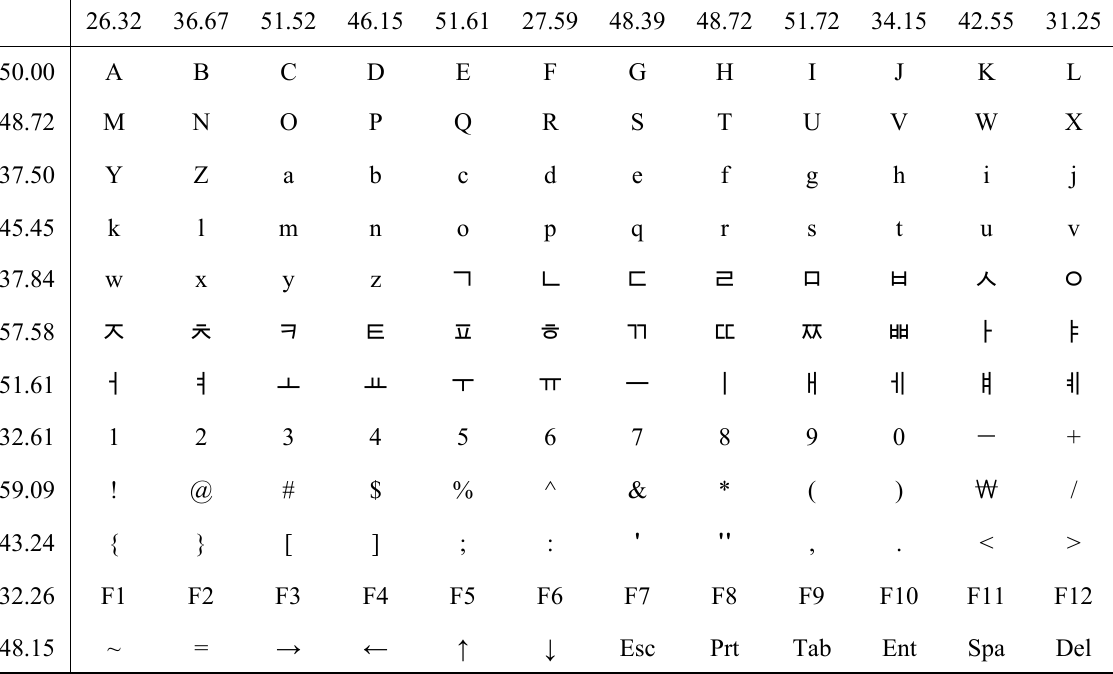
Table 5. Horizontal and vertical accuracies using the proposed method (unit: